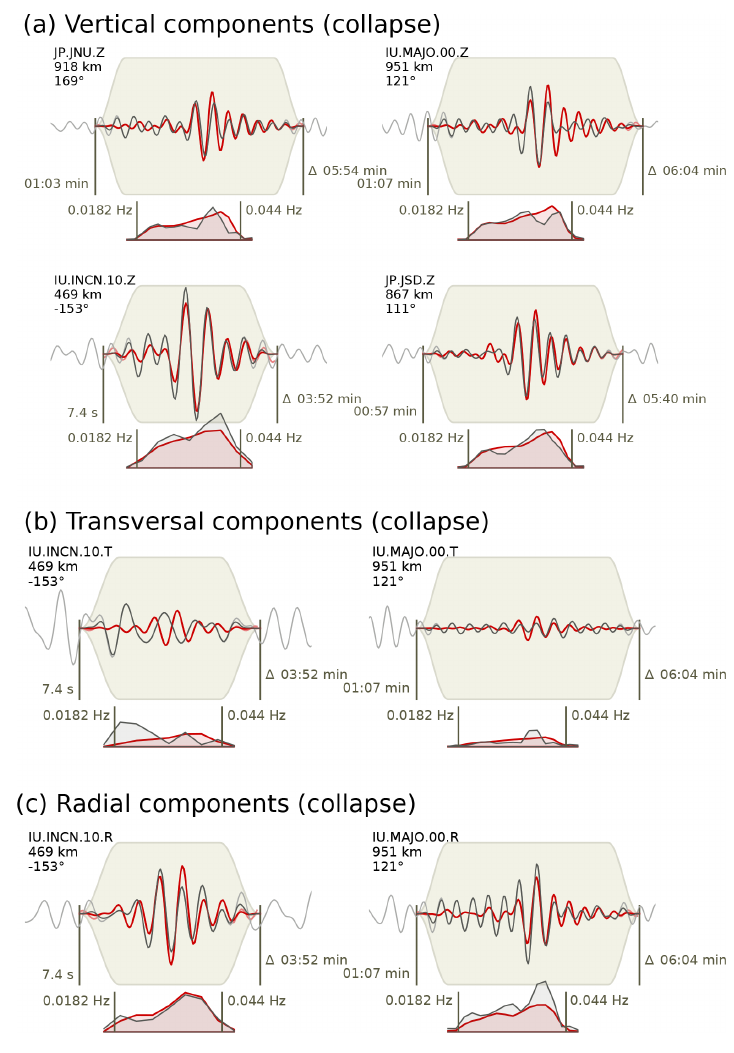
Figure 7. Same as Fig. 5 but for the aftershock around 8min after the test.